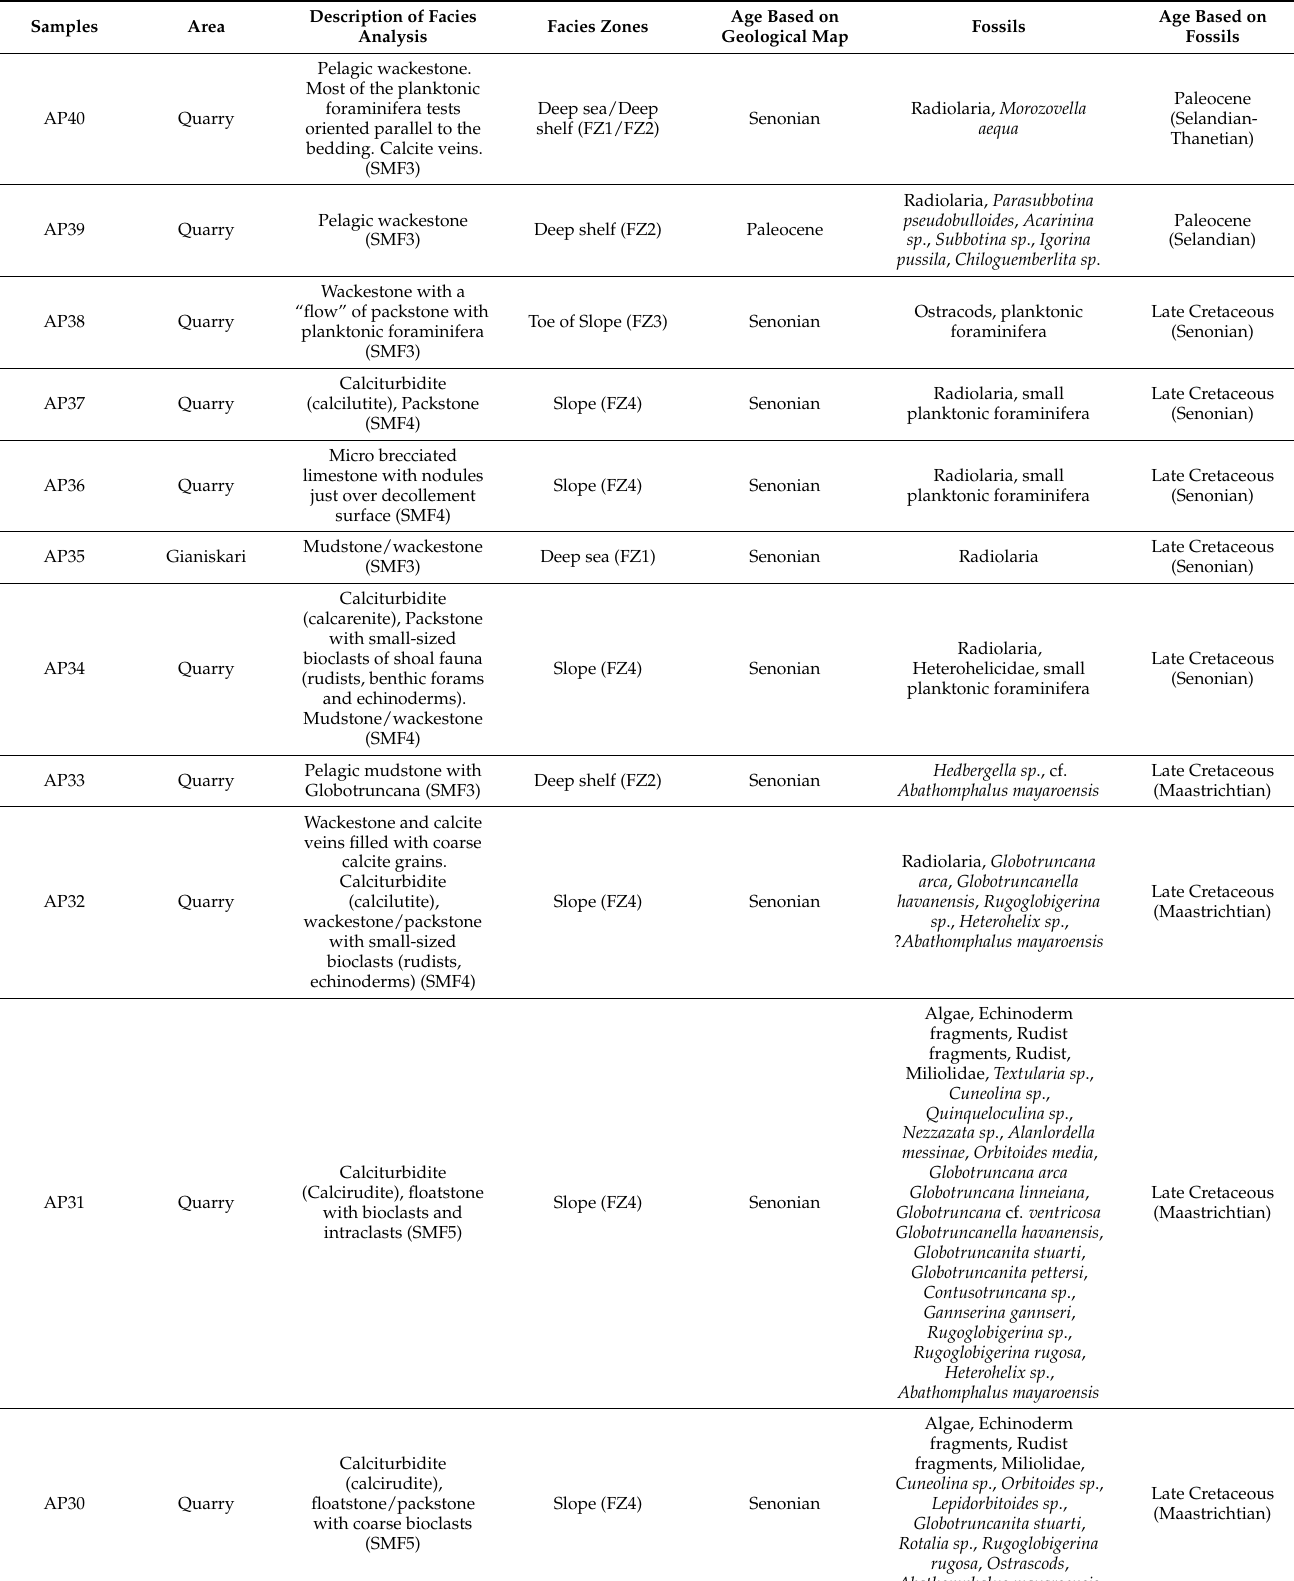
Table 2. Detailed description of studied thin sections where depositional facies, fossils, and the age of the studied deposits are presented in Araxos